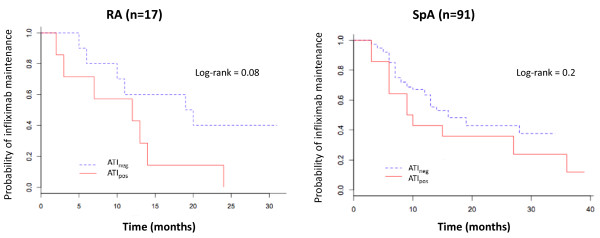
Infliximab maintenance according to ATI status in RA and SpA patients. ATI: antibodies toward infliximab; ATIpos: ATI detected at least once during follow-up; ATIneg: ATI not detected.